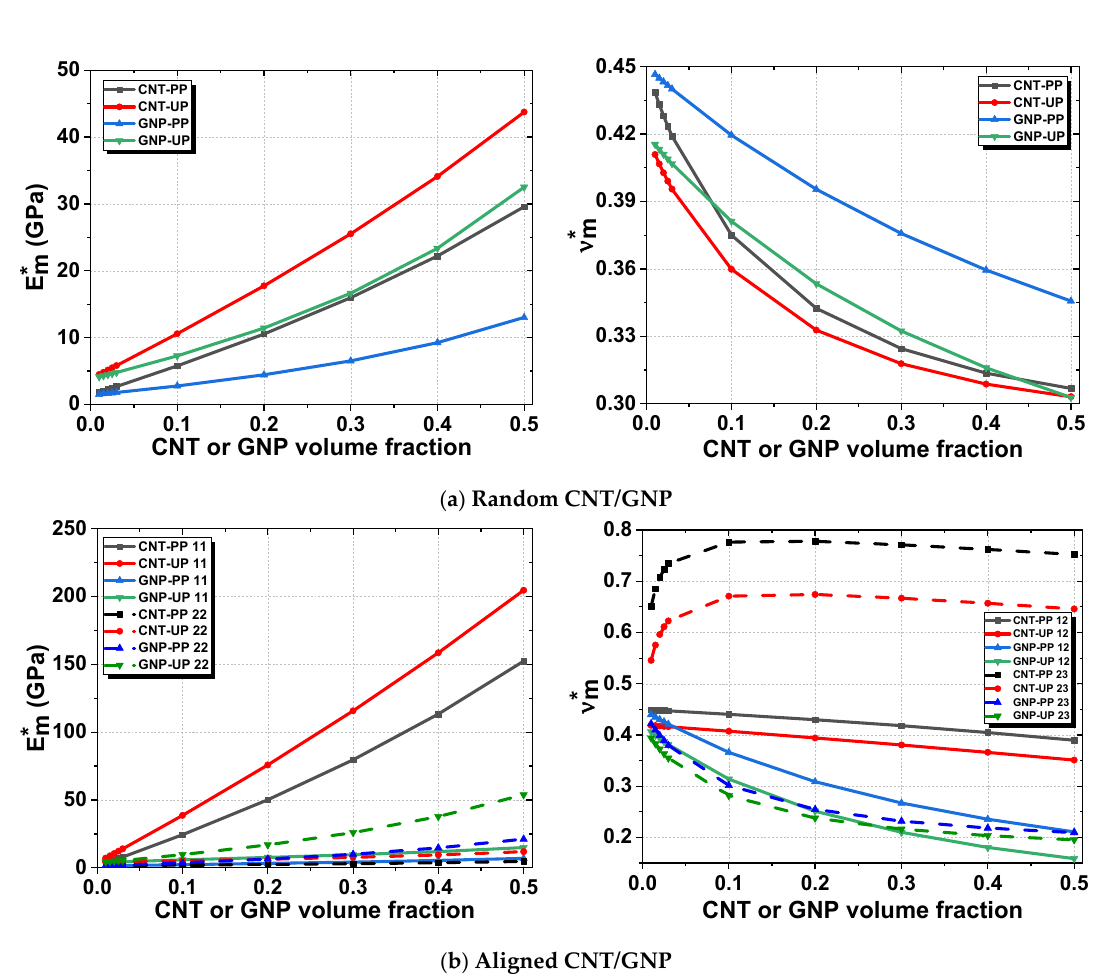
Figure 7. Effective elastic property of polymer reinforced by random ( a ) and aligned ( b ) CNT/GNP nanofillers. To conclude, in longitudinal direction 11, CNT-reinforced UP has enhanced elastic properties, and for transversal direction 22, GNP-reinforced UP has higher mechanical properties, which is explained by the molecular structure of CNTs and GNPs (Figure 8). Additionally, Young’s modulus E ∗ and Poisson’s ratio ν ∗ of CNT and GNP inclusions are better than those of UP and PP polymers.